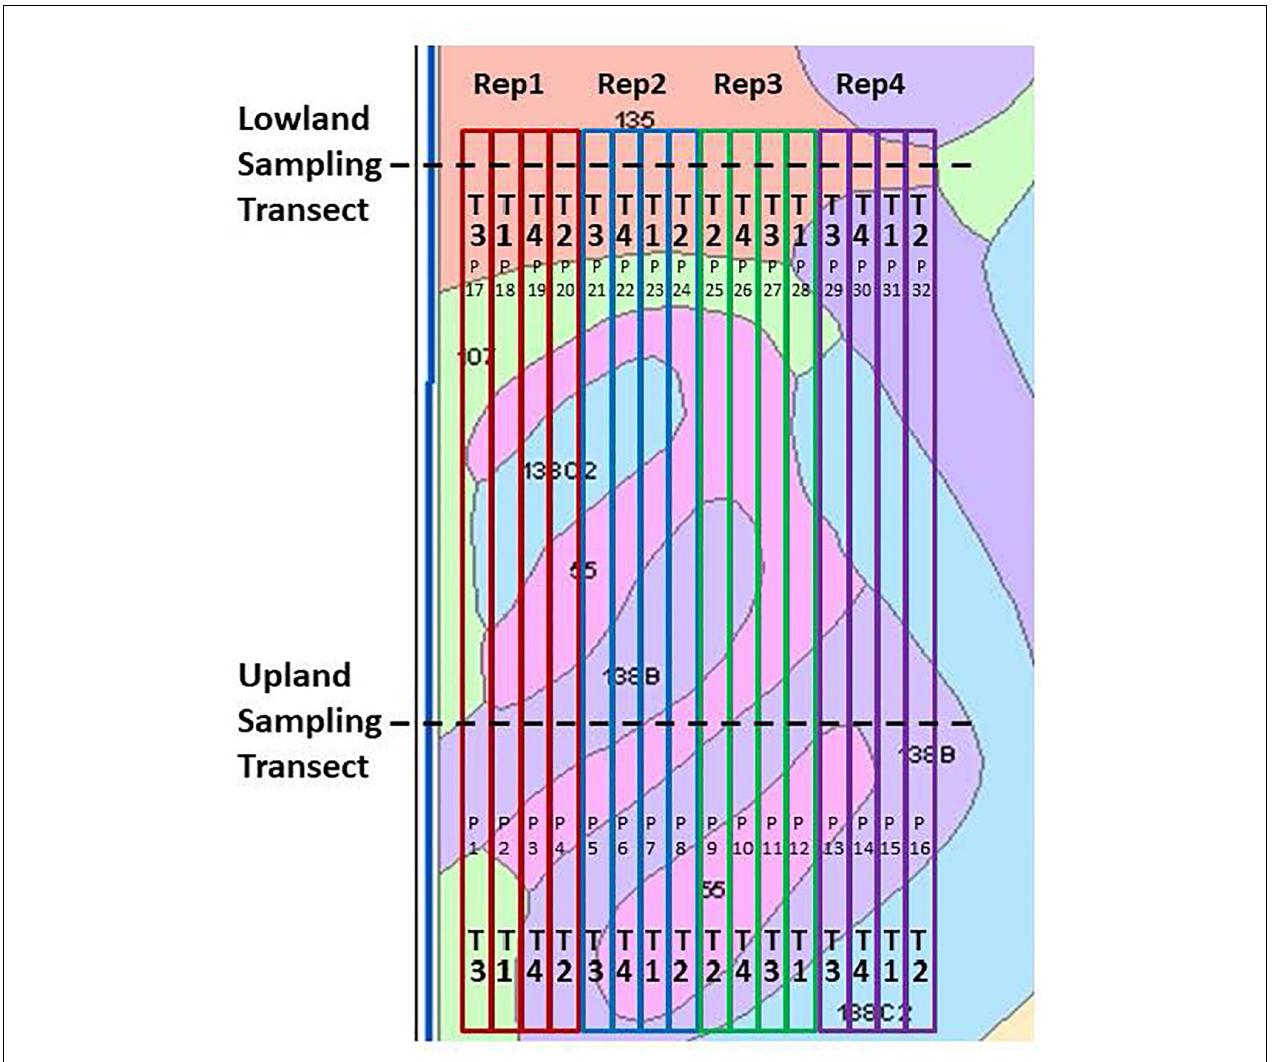
FIGURE 2 | Field design of the Ames on-farm field research site location, shown with soil mapping units and boundaries of the field-long treatment strips. Key to treatments (“T”): T1, Control lacking Enersol humic product application; T2, lower rate of Enersol humic product application; T3, higher rate of humic product application and T4, a separate alkali-extracted humic product. Exact application rates changed among years, as explained in the text. Plot numbers are shown as “P.” Key to soil mapping units: 55, Nicollet loam, 1 to 3% slopes; 107, Webster silty clay loam, 0 to 2% slopes; 135, Coland clay loam, 0 to 2% slopes, 138B, Clarion loam, 2 to 5% slopes; and 138C2, Clarion loam, 5 to 9% slopes, moderately